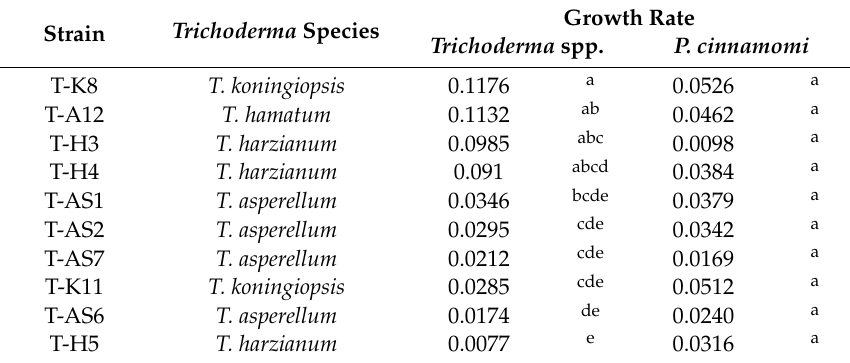
Table 4. Test of means of the growth rate of Trichoderma spp. and Phytophthora cinnamomi . Strain Trichoderma